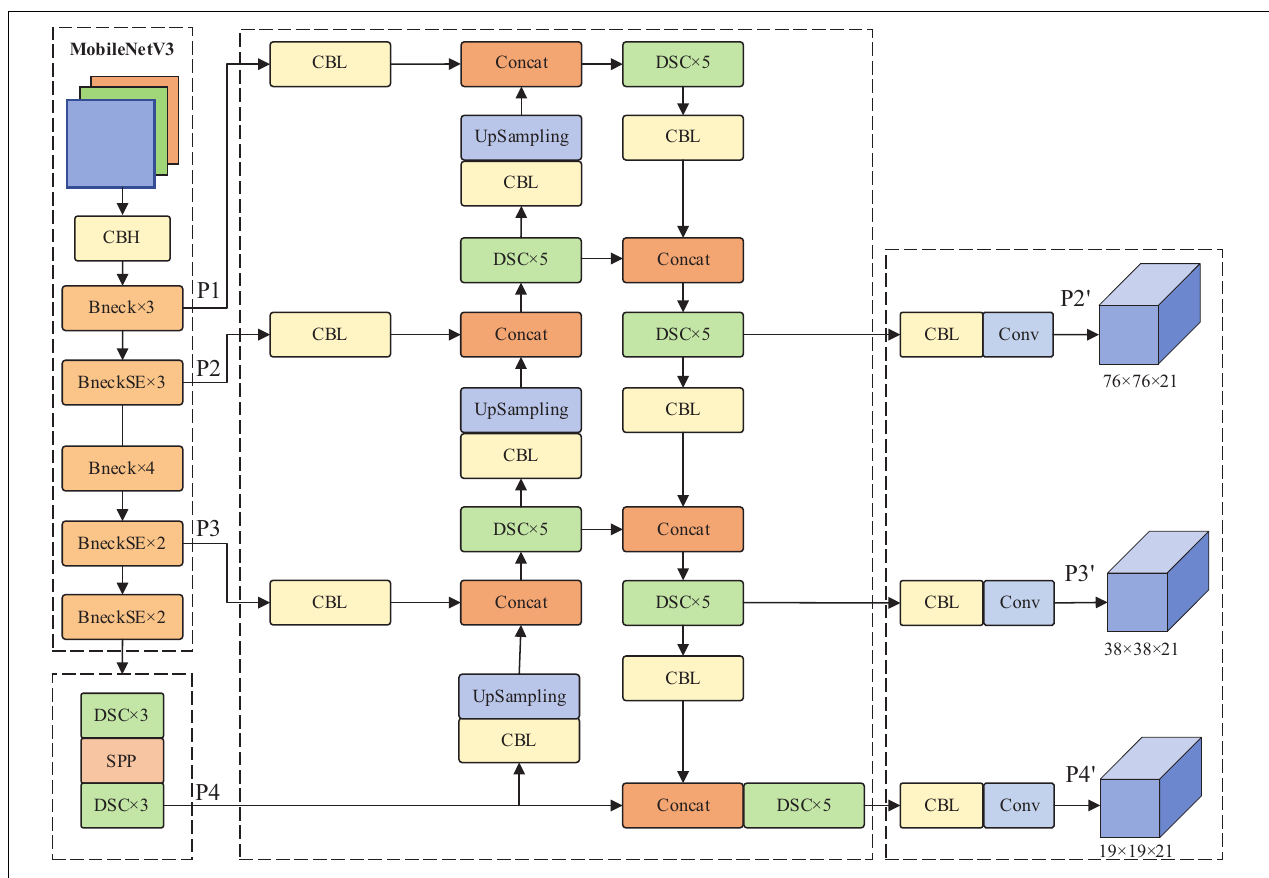
FIGURE 4 | The structure diagram of improved